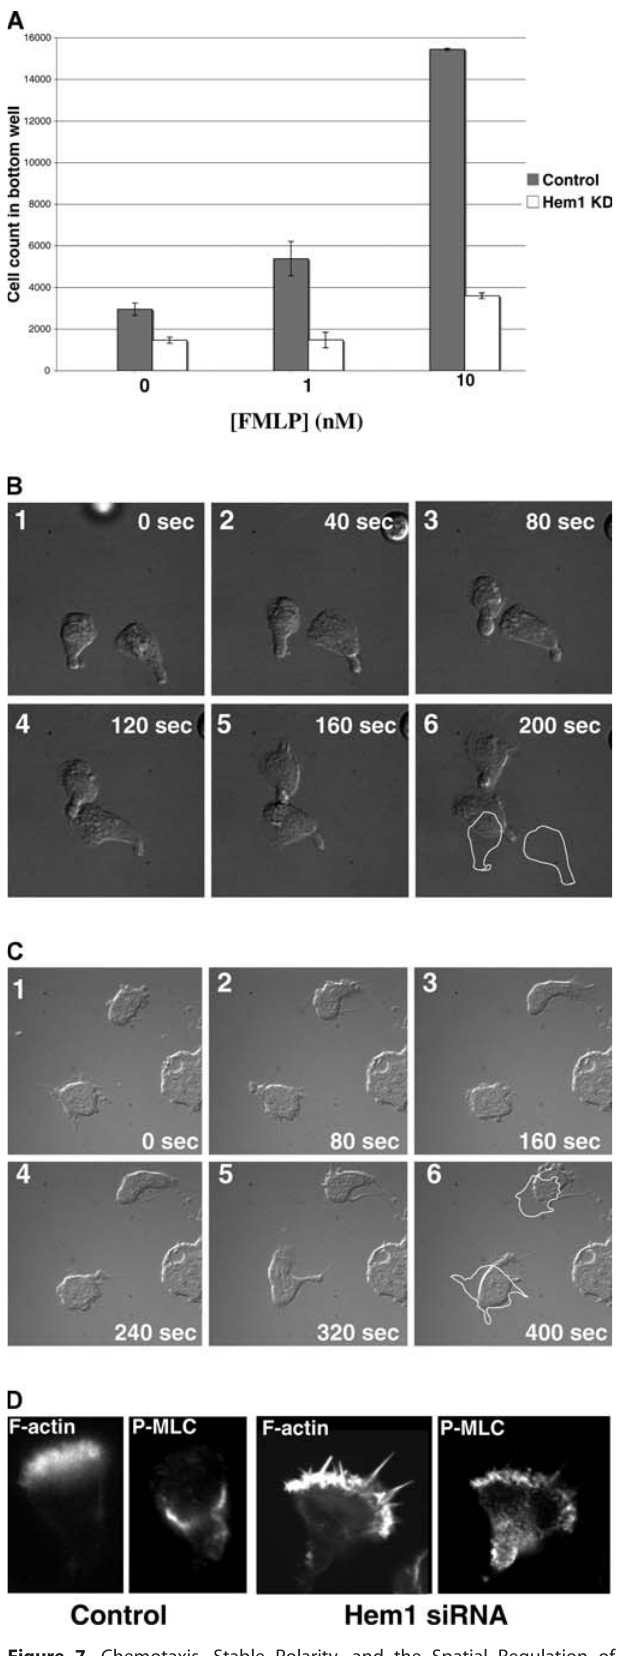
Figure 7. Chemotaxis, Stable Polarity, and the Spatial Regulation